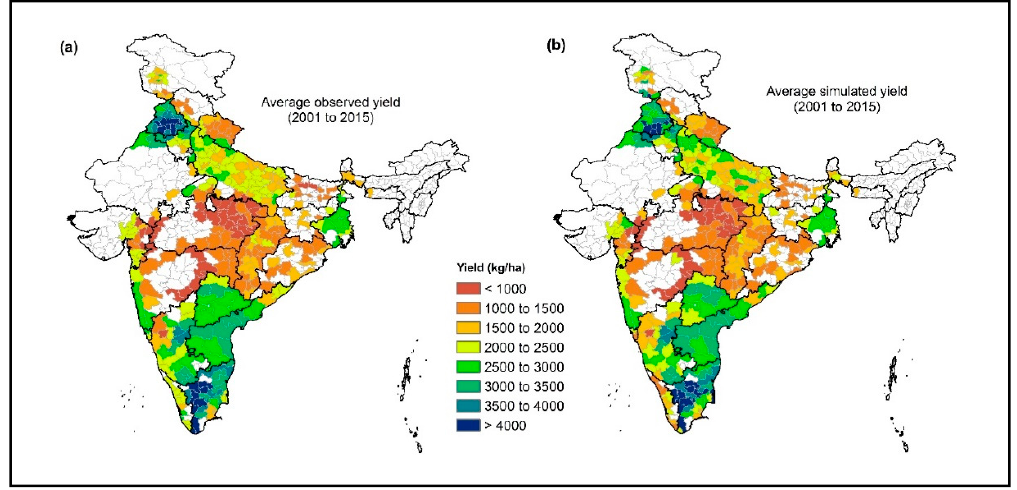
Figure 2. The spatial distribution for district-wise observed and simulated long-term average yield